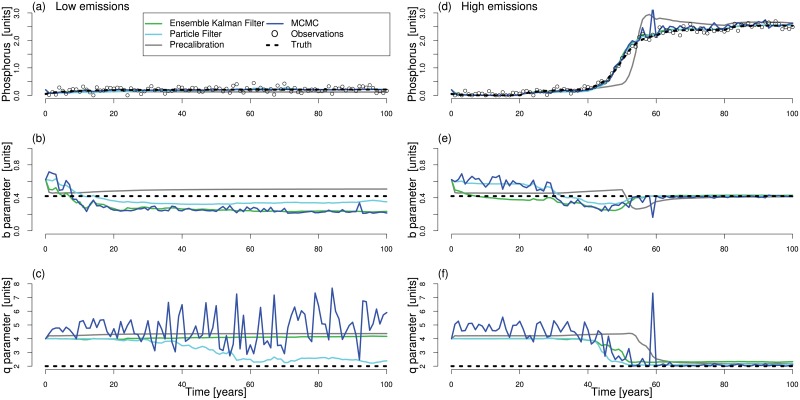
Mean trajectories from each data assimilation scheme.Mean learning trajectories (y-axis) for (a, d) phosphorus in the lake, (b, e) loss parameter, b, and (c, f) recycle parameter, q, as a function of learning time (x-axis) for (a-c) low emissions and (d-f) high emissions strategies. EnKF, PF, PC, and MCMC learning trajectories are shown by green, sky blue, gray, and dark blue lines, respectively. The assumed true values of parameters and resultant phosphorus trajectory are shown by dashed black lines. Empty black circles show the synthetic observations of phosphorus in the lake. Each data assimilation method uses 5 million NFEs, excluding overheads which differ for each method.